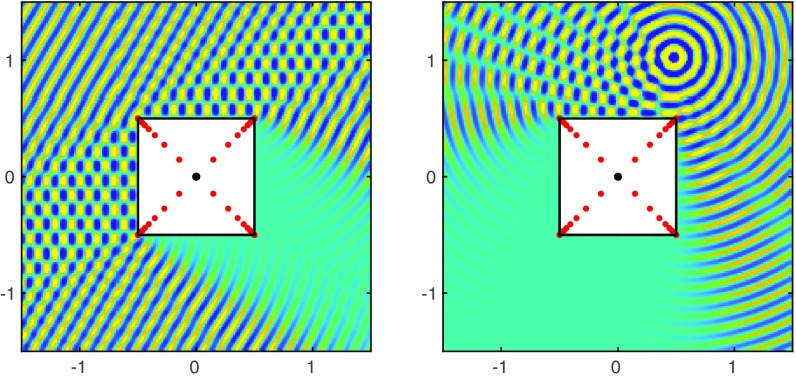
Helmholtz equation. Solutions to Δu+k2u=0 with k=50 in the exterior of a square (the real part is plotted). The incident signal on the left is a plane wave oriented at 30°, and on the right, a point oscillation H0(k|z−z0|) with z0=1/2+i.